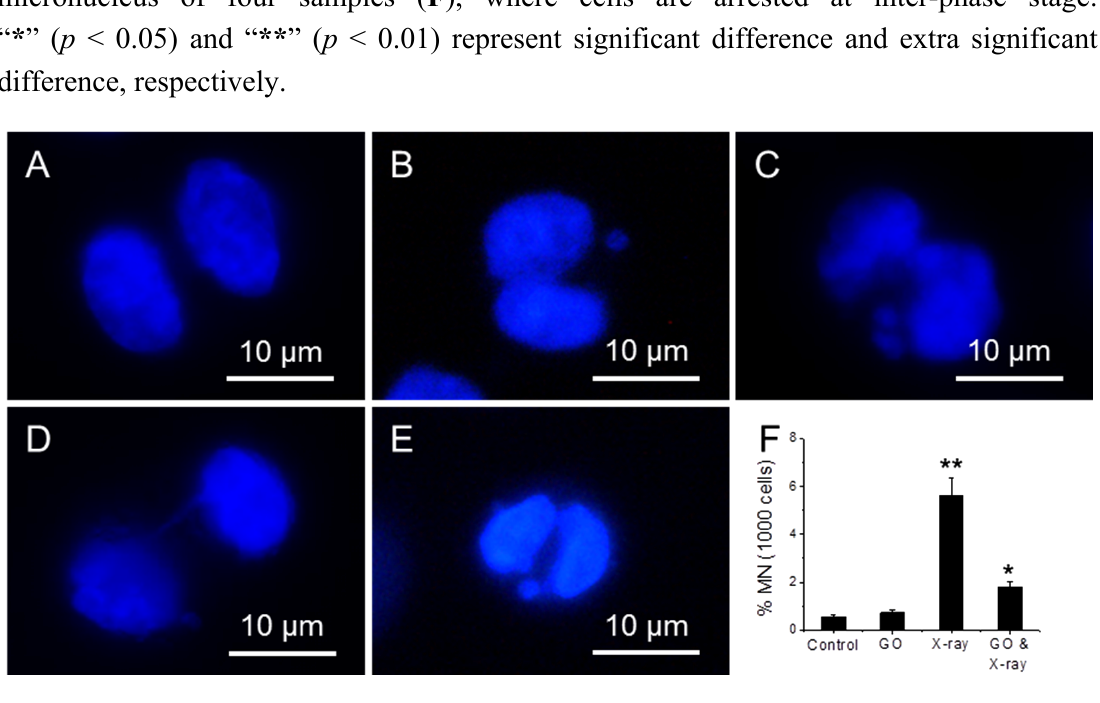
comparison, the frequency of micronucleus in GO treated and X-ray exposed cells is 1.8%, which is